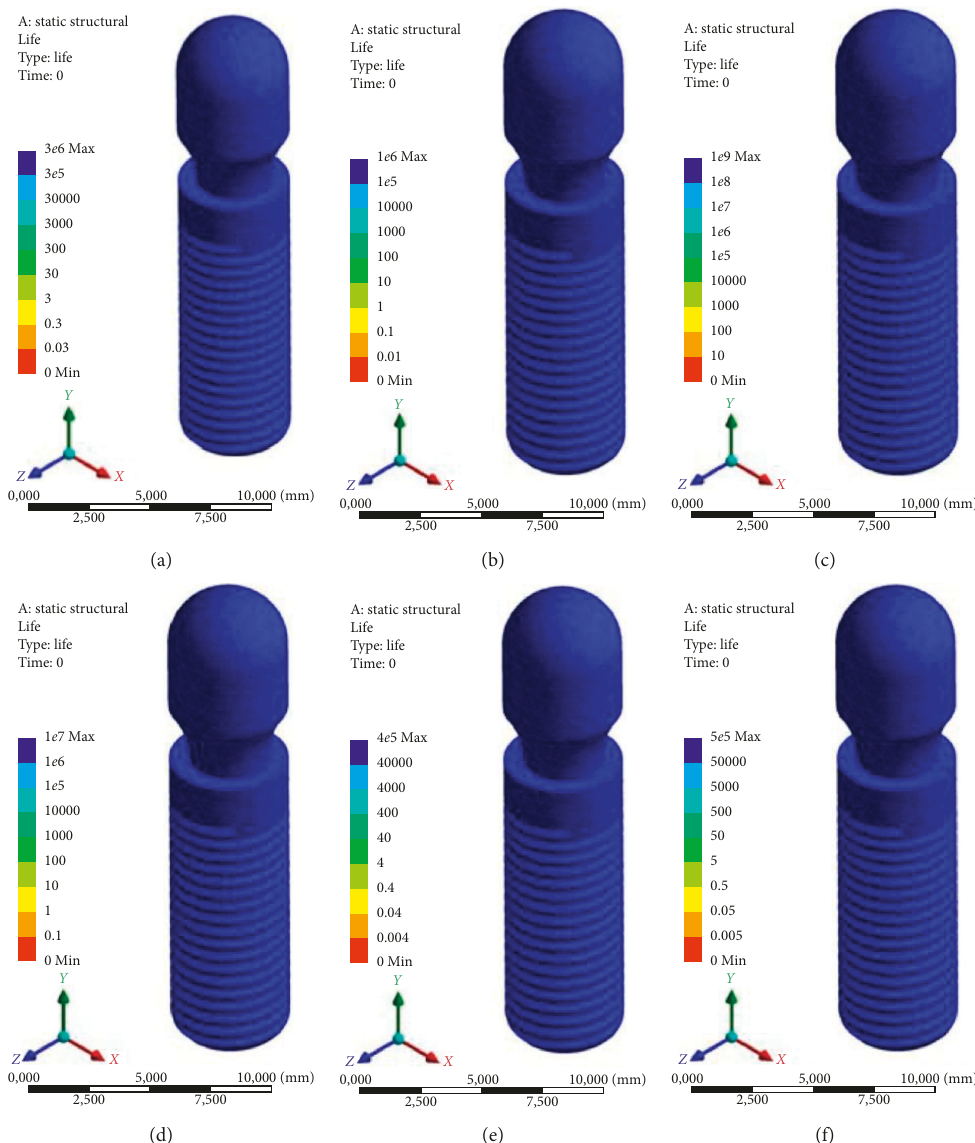
Figure 5: Fatigue life results of implants. Implant materials are AISI 316L stainless steel (a), nanoporous anodic alumina (b), L-605 CoCr alloy (c), cp Ti with the nanotubular TiO 2 surface (d), YSZ (e), and ZTA